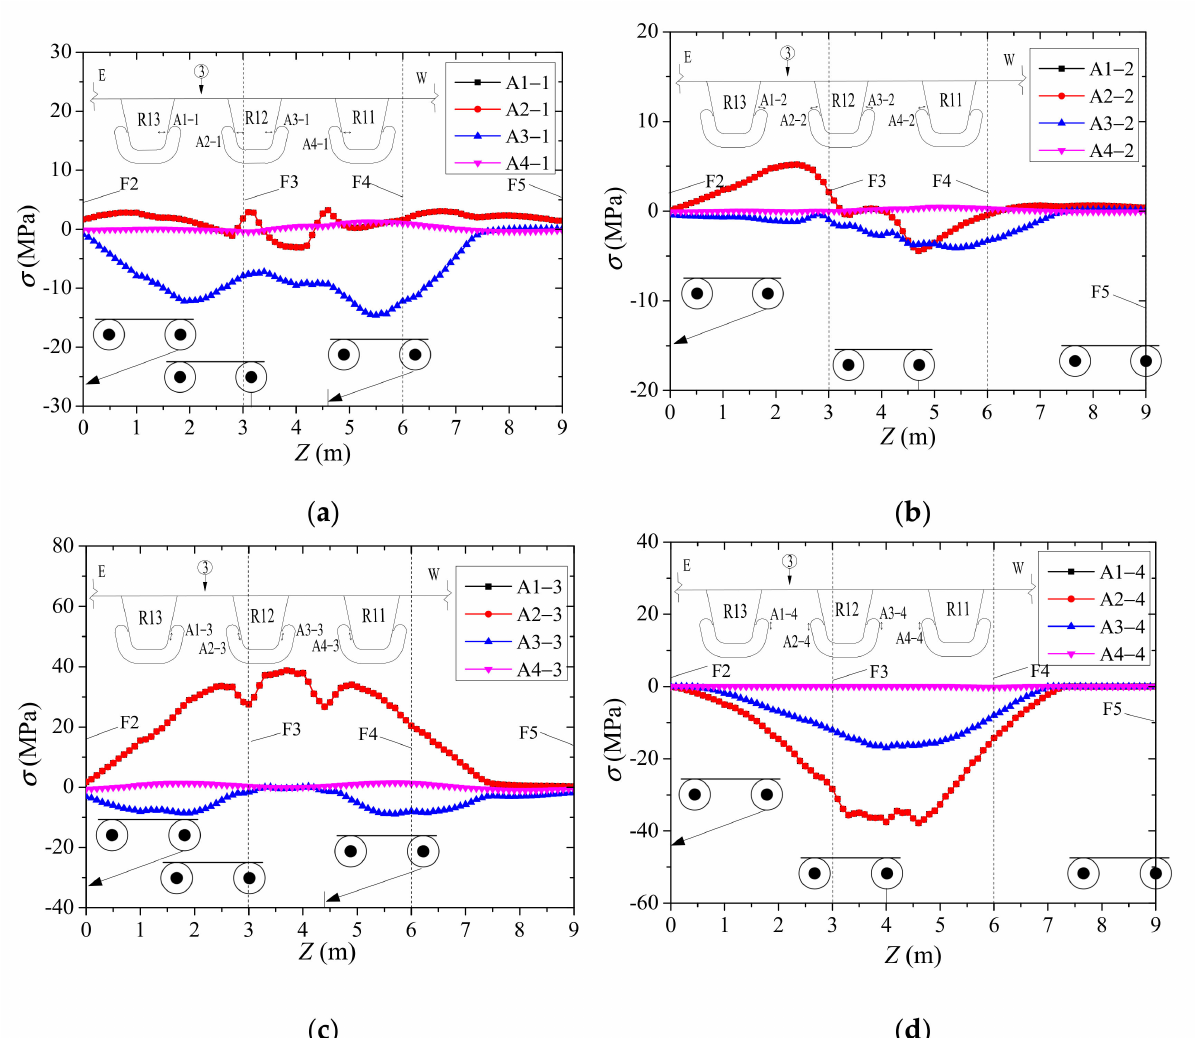
Figure 18. Calculated stress of the four details under LC3. ( a ) RF-R; ( b ) RF-F; ( c ) RF-W; ( d ) Cutout.